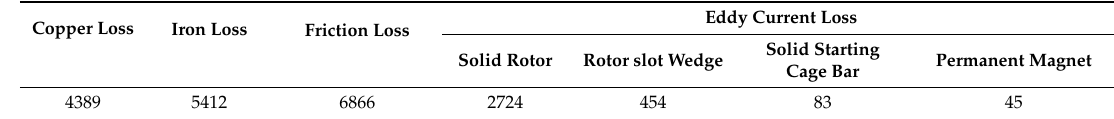
Table 3. Losses of HVLSSR-PMSM